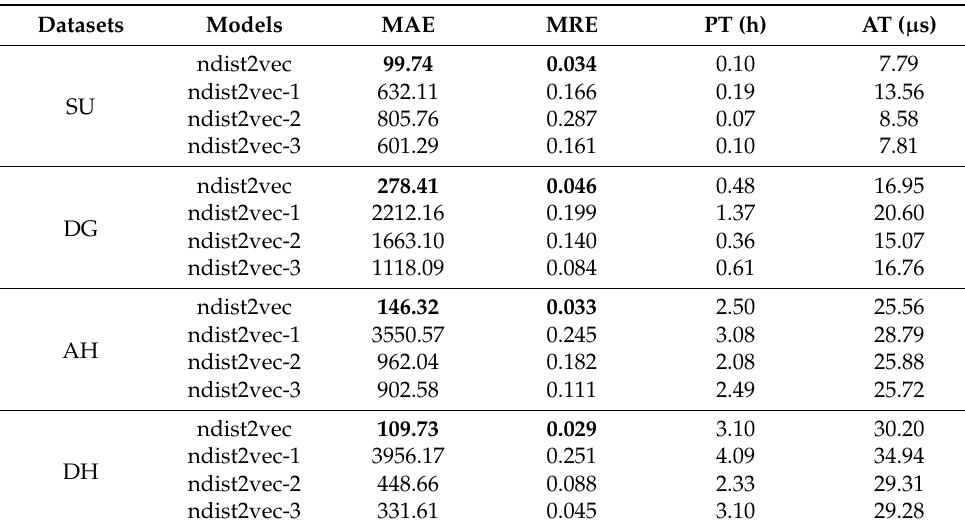
Table 4. Comparison results of ndist2vec and three variant